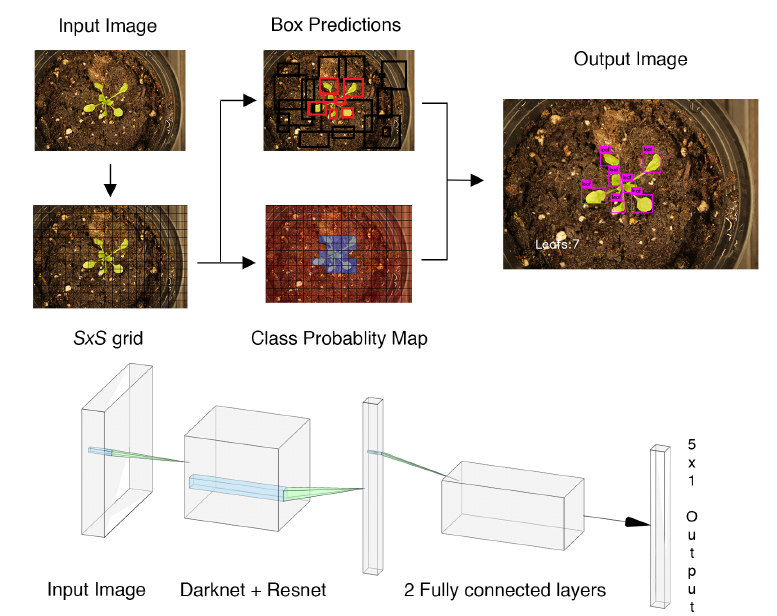
Figure 1. You Only Look Once (YOLO) framework taking an image as input into a deep convolutional neural network and outputs the leaf detection, where the bottom part of the figure consists of a diagram of the YOLO network